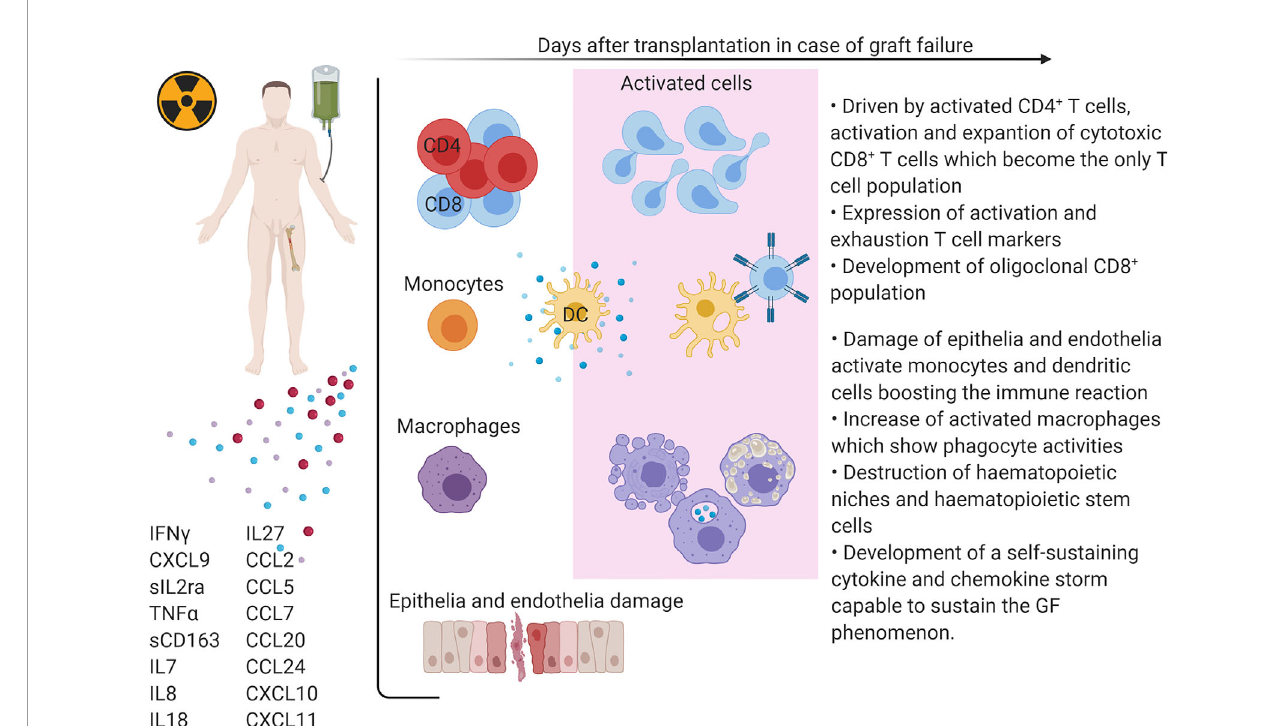
FIGURE 3 | Schematic representation of GF pathophysiology after HSCT.